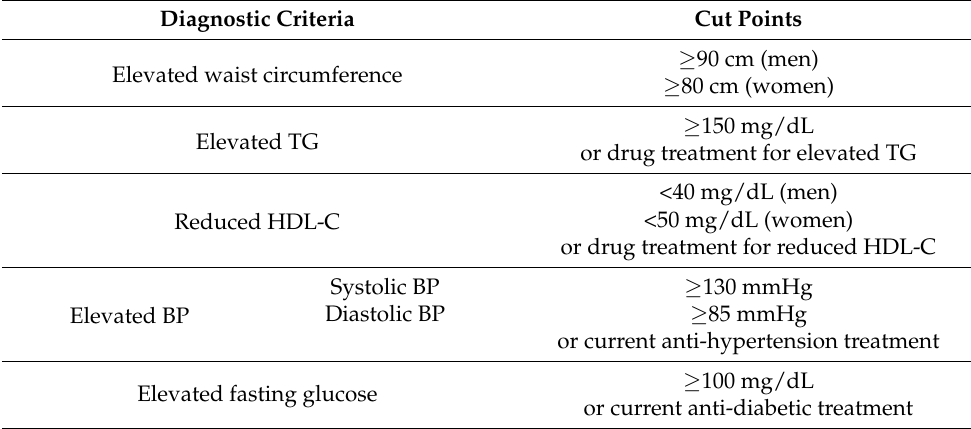
Table 1. Diagnostic criteria for metabolic syndrome.